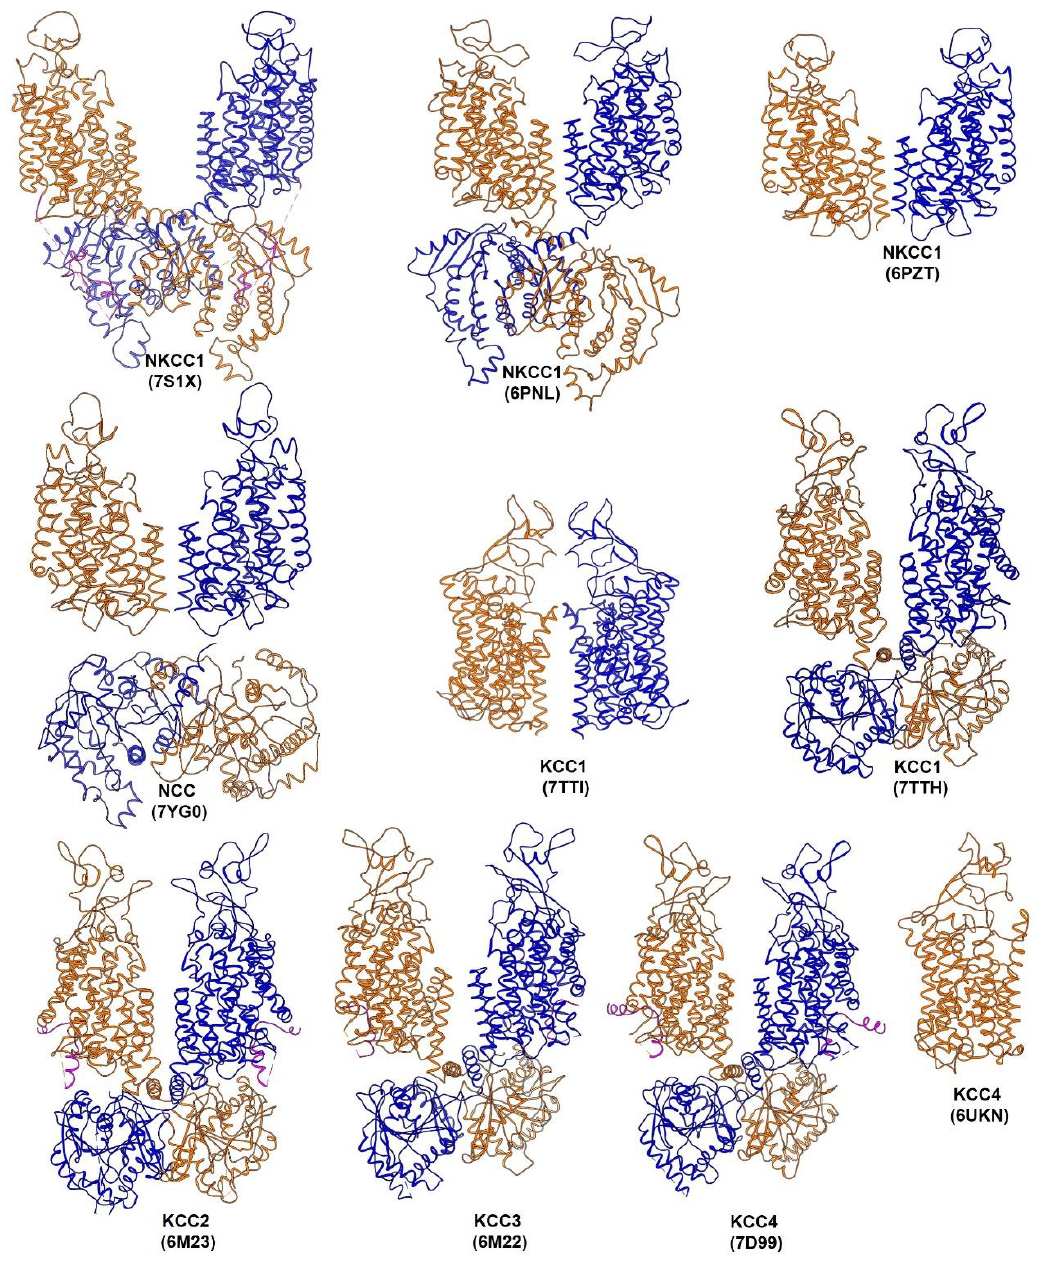
Figure 2. A gallery of cryo − EM structures of CCCs. All CCCs assume a dimeric architecture, except that KCC4 can also exist as a monomer. Two subunits in a CCC dimer are colored red and blue. The NKCC1 N − terminal phosphoregulatory segment and KCC N − terminal autoinhibitory segment are shown in magenta.